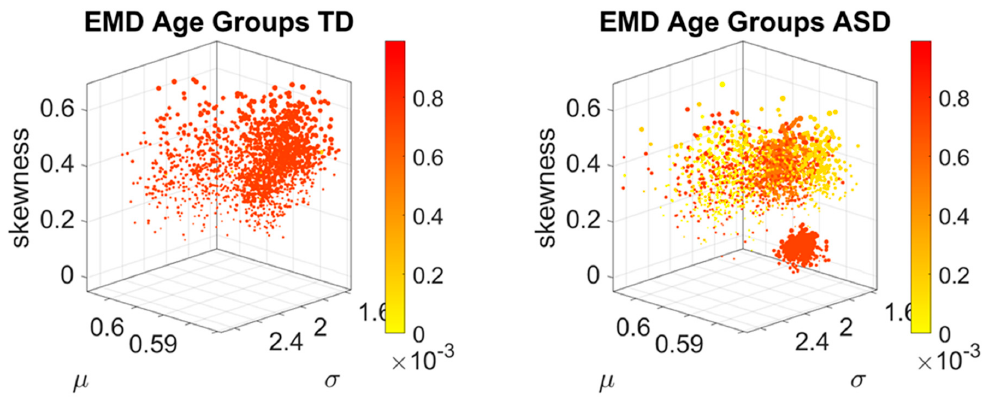
Figure 4. Normative stochastic signatures of cross-section of neurotypical population vs. Autism Spectrum Disorders (ASD) signatures from age-matched groups, empirically estimated from the involuntary head displacements (micro-movement spikes reflecting fluctuations in linear speed). Scatters show high heterogeneity in ASD according to the ranges of pairwise Earth Mover’s Distance (EMD) values (color coded normalized while considering the full range of values from both cohorts.).